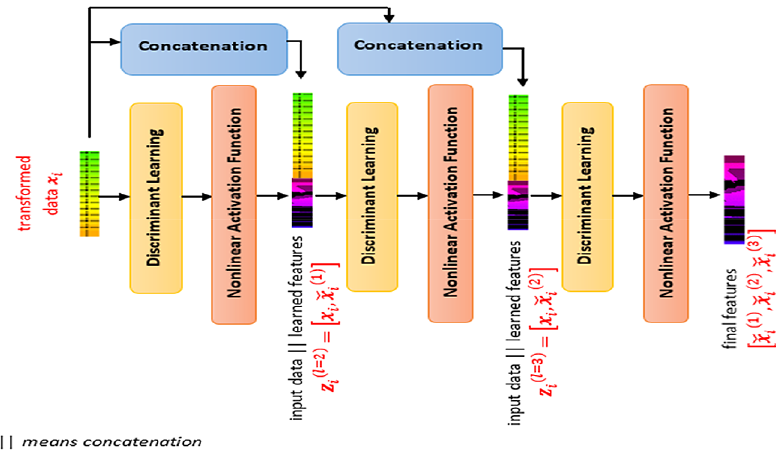
Figure 2. Stacked Discriminant Feature Learning (SDFL)